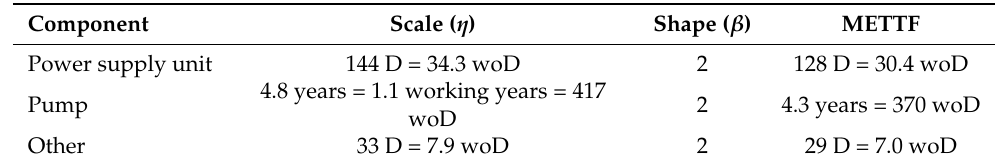
Table 3. ETTF distribution parameters and METTF for the spraying cabin (GORENJE), ignoring the already occurring lifetime extension thanks to time-based inspection.